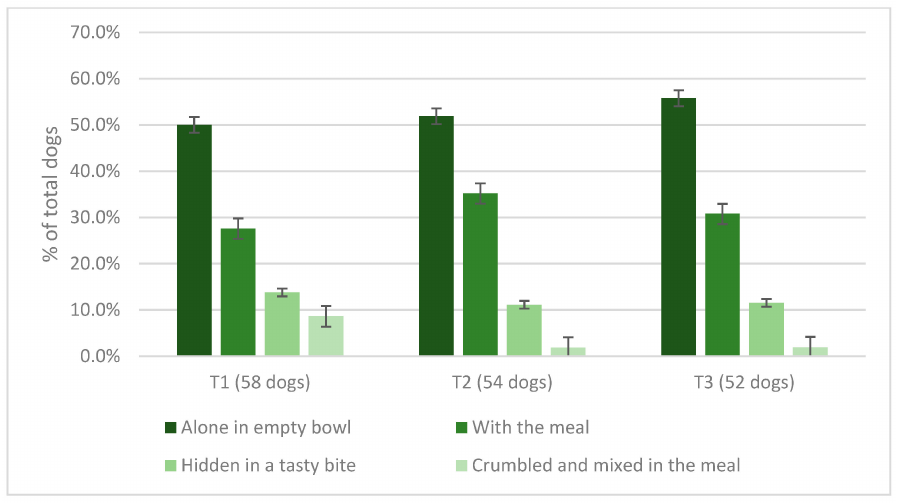
Figure 1. Method of offering of the increasing amounts of Spirulina offered to dogs at T1, T2, and T3 of this